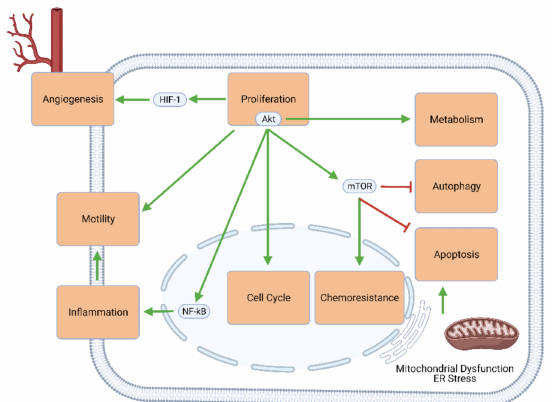
Figure 1. Intracellular signaling mechanisms involved in GBM development and progression. El- ements of proliferative signaling pathways—especially Akt and mTOR—promote angiogenesis, motility and migratory potential, neuroinflammation, cell cycle progression, chemoresistance, and tumor metabolism, and concurrently inhibit GBM cell death through apoptosis and